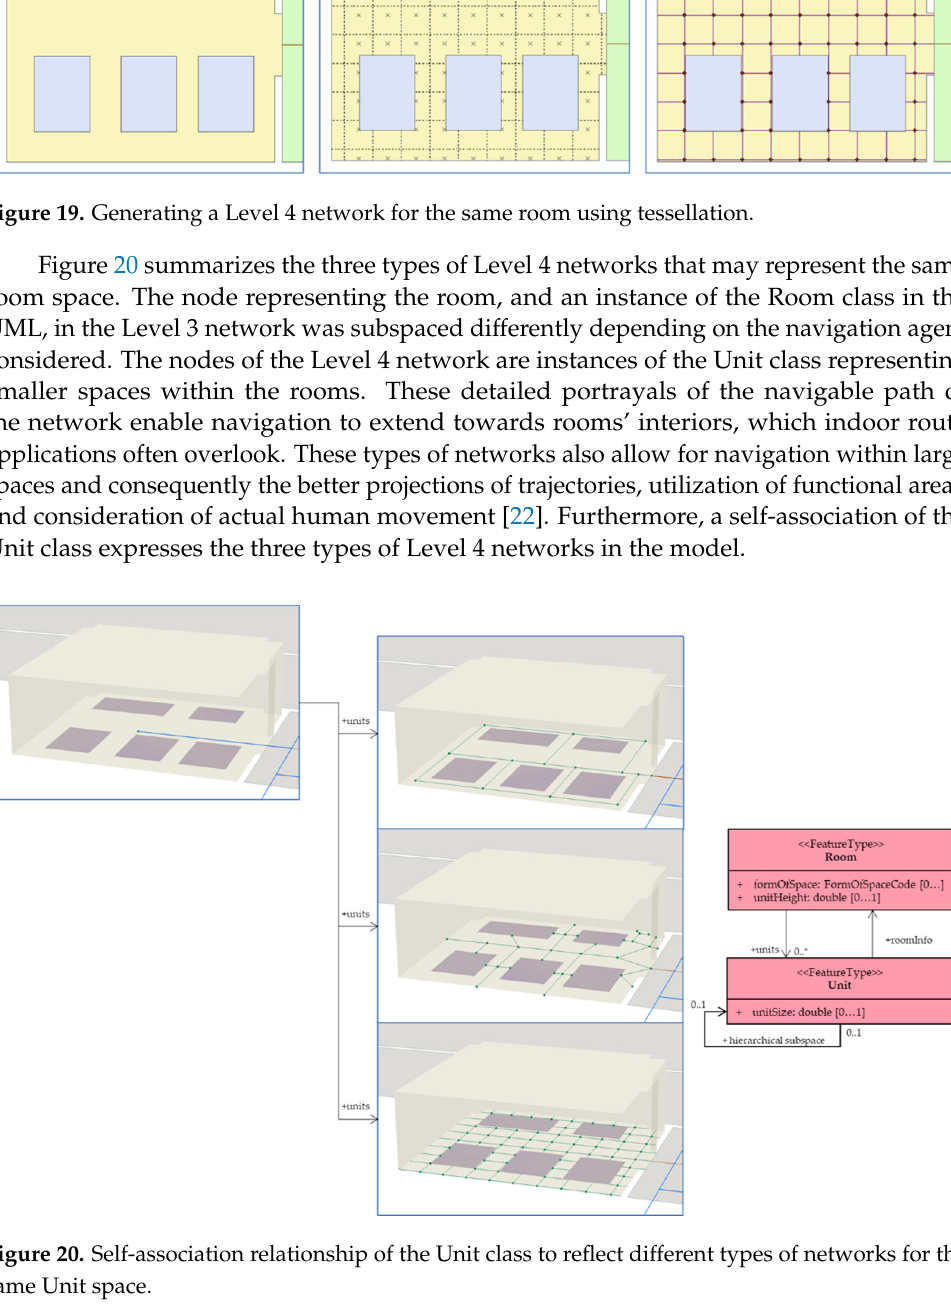
Figure 18. Generating a Level 4 network for a room using Z-buffering.